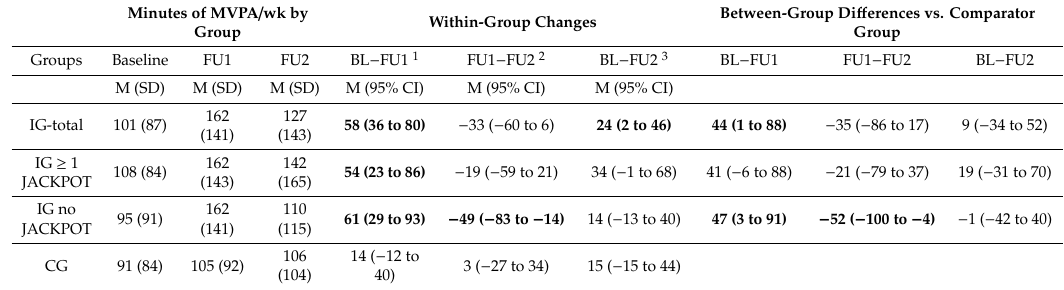
Table 3. Short and long-term intervention e ff ect on accelerometer-assessed physical activity behaviour. Minutes of MVPA / wk by Group Within-Group Changes